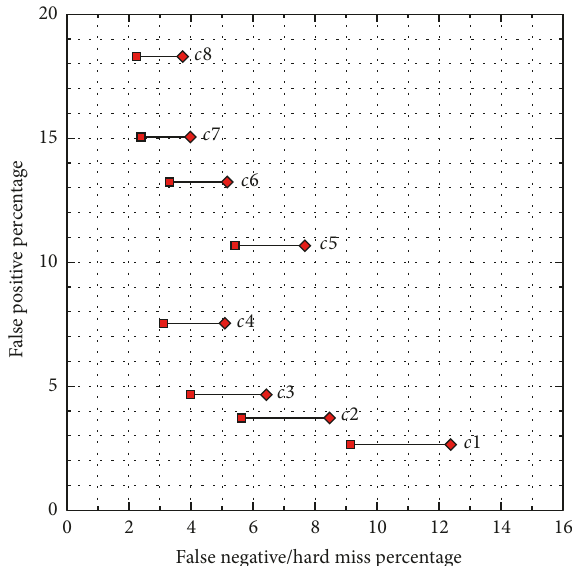
Figure 6: Trade-off between false positives and false negatives on the A27. Diamonds indicate the false negative percentages while the squares denote the hard miss